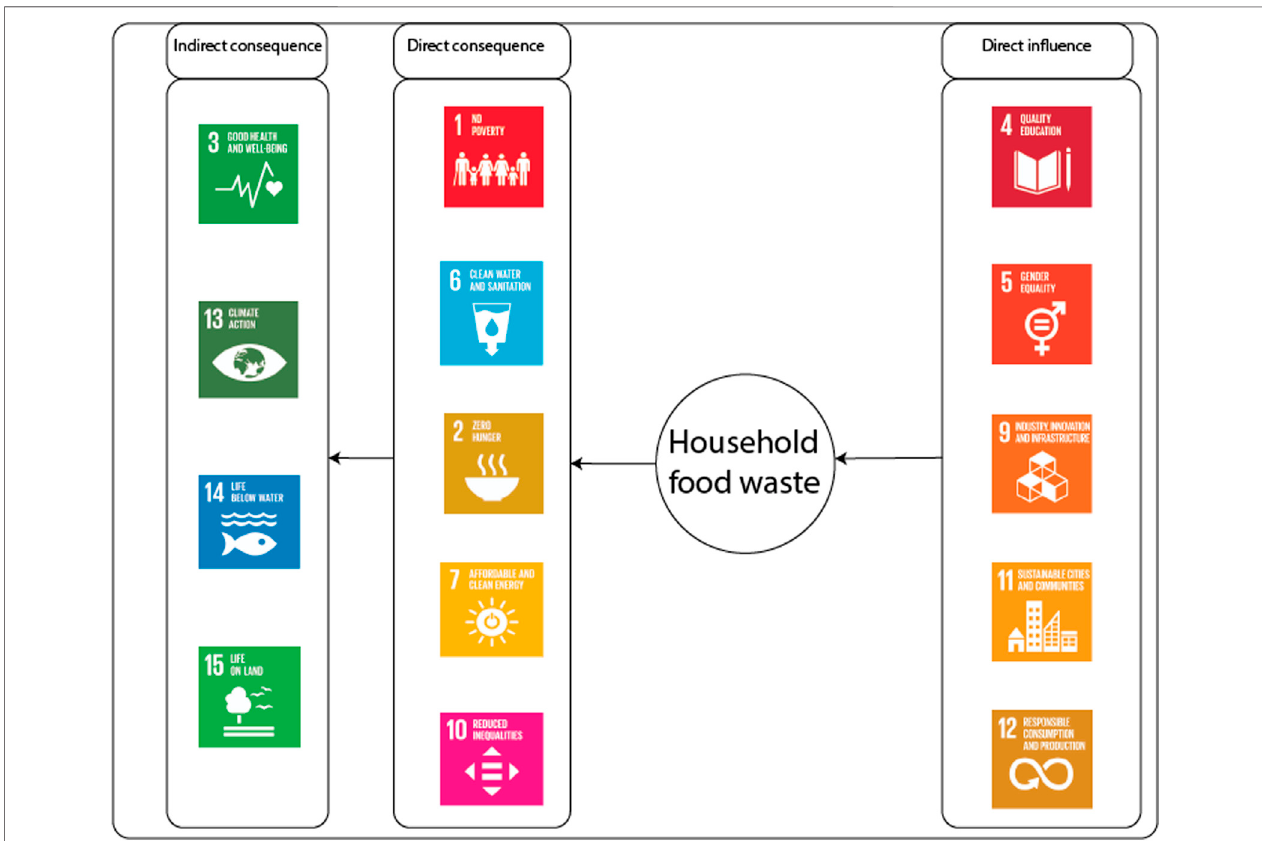
FIGURE 1 | Direct and indirect effects of food waste reduction on the achievement of the Sustainable Development Goals of the UN.